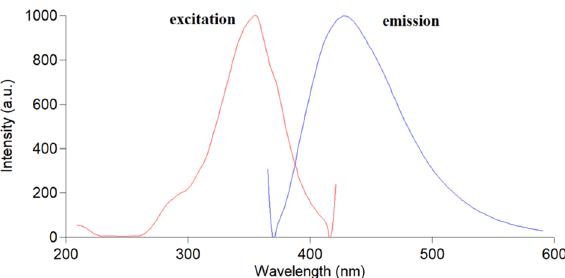
Figure 2. Fluorescence emission spectrum of SN-CQDs at 430 nm after excitation at 360